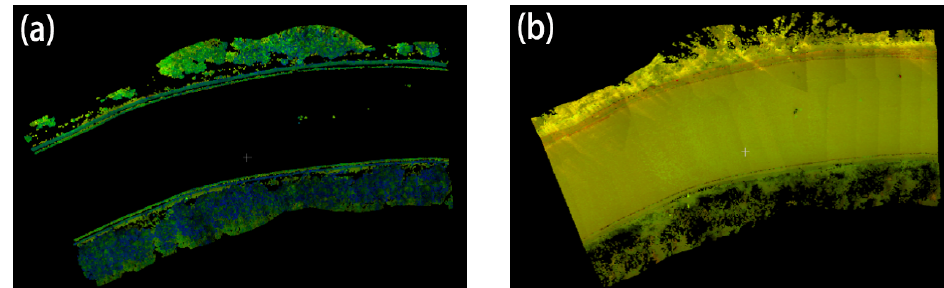
Figure 13. Selecting a range of intensity values of the first laser point cloud datasets in region A for segmentation: ( a ) selection the starting value; ( b ) selection the ending value. The intensity statistical histogram based on the Figures 14 and 15 indicates that the intensity segmentation range of the second laser point cloud datasets in region A is 47,587 to 53,488. The result of point cloud sets segmentation is shown in Figure 16, where ( a ) is the non-ground points and ( b ) is the ground points.